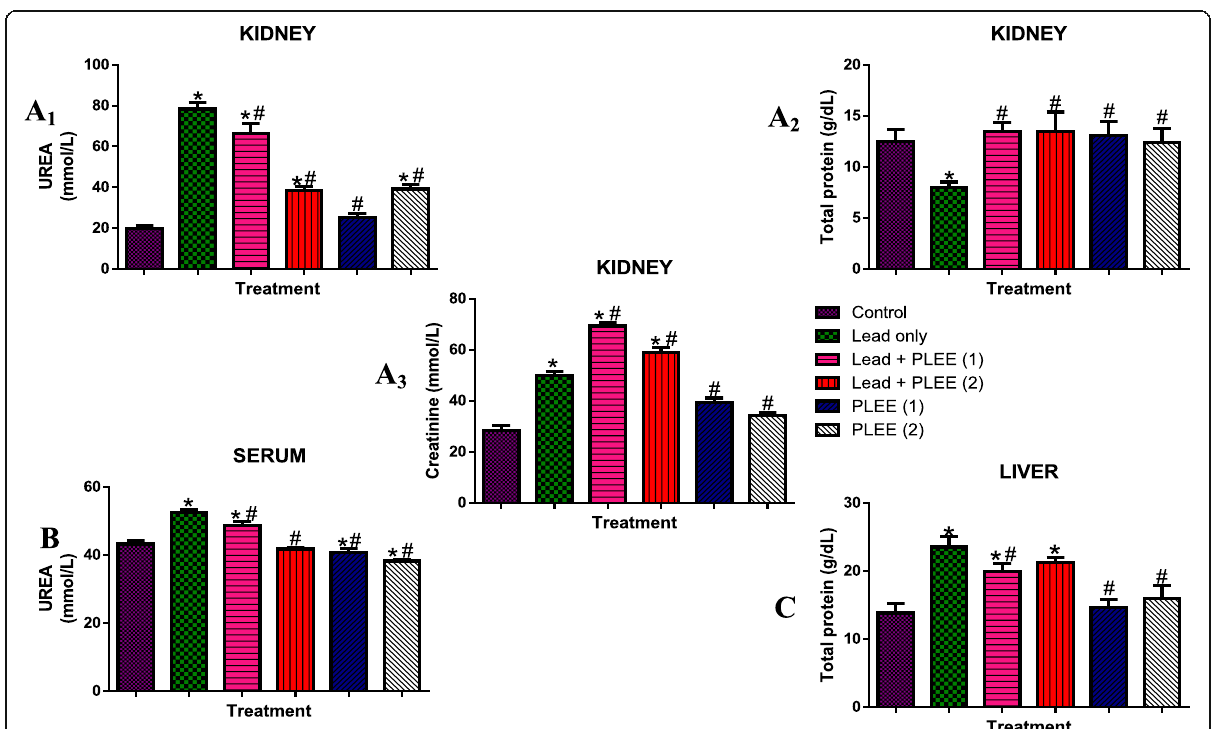
Fig. 2 Changes in the levels of urea, creatinine and total protein in hepatorenal toxicity induced with lead acetate and treated with PLEE in Wistar rats. Results are represented as mean ± SD ( n = 5). *- Significantly different from the negative control group, #- significantly different from Lead-only group ( p <